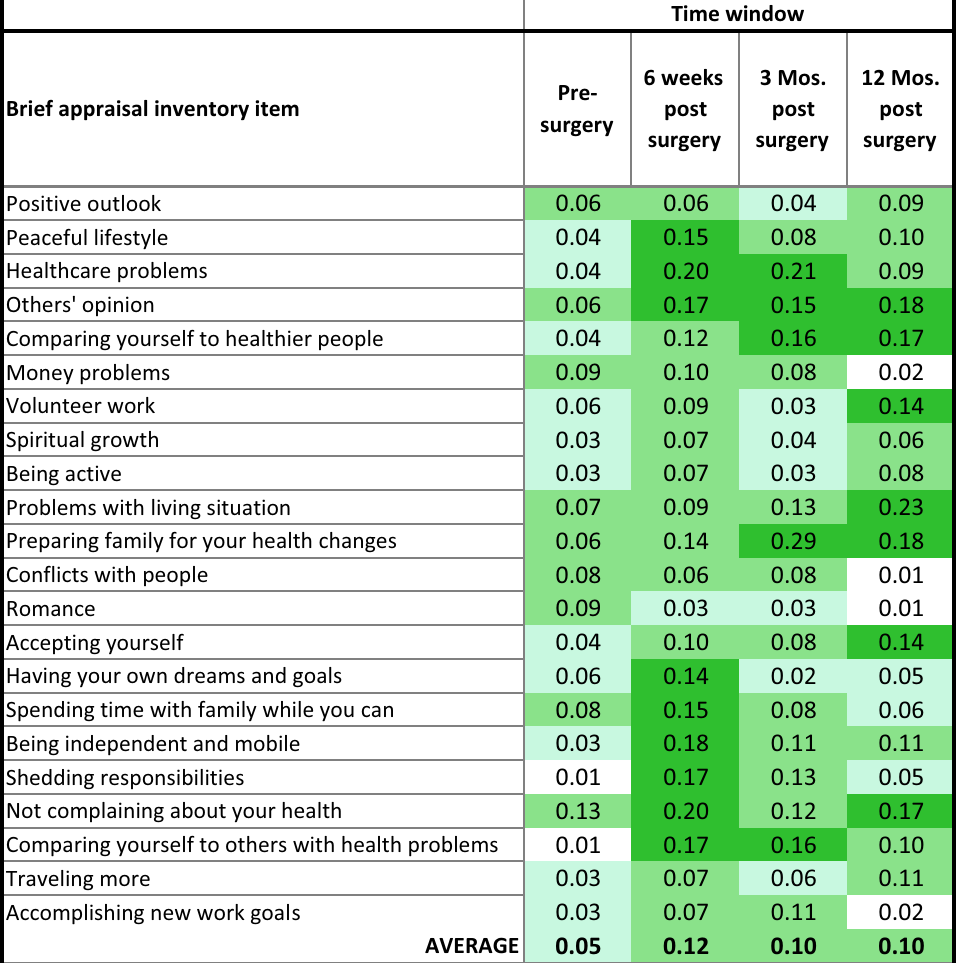
Table 2 HOOS: Eta 2 in one-way ANOVA